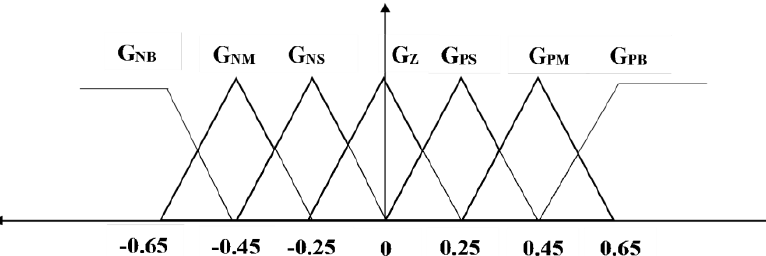
Figure 8. New revised input membership functions based on variable G.